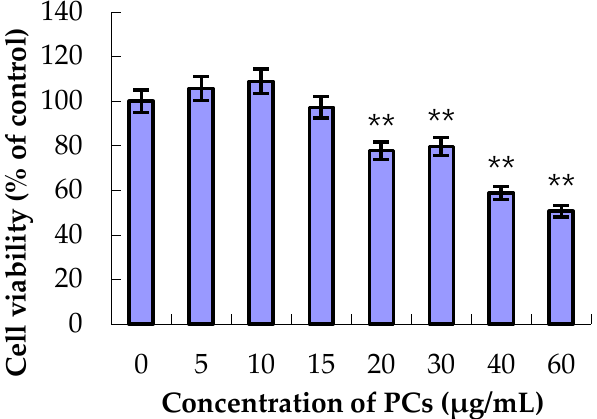
Figure 1. Effects of different concentrations of proanthocyanidins (PCs) on the viability of MODE-K cells. The relative survival rates of MODE-K cells did not decrease at PC concentrations of 5, 10, or 15 μg/mL. However, when the concentration of PCs was 20 μg/mL or higher, the relative survival rate of the MODE-K cells decreased significantly. ** p < 0.01 vs. control group.